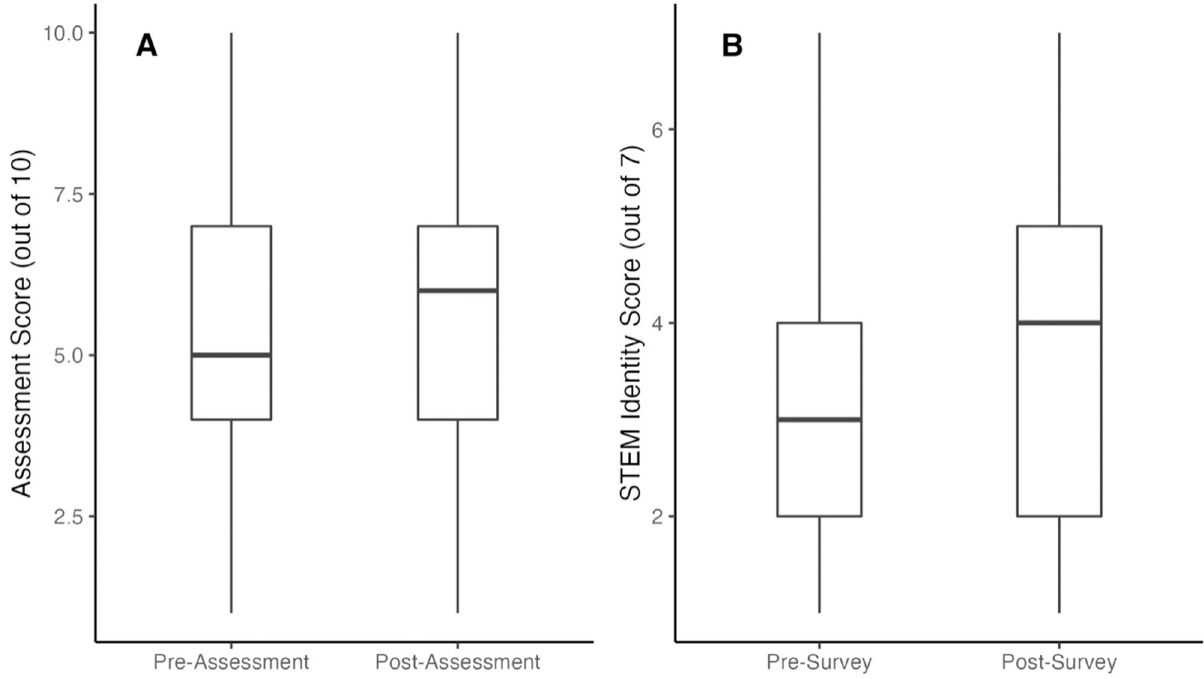
Fig 4. Student raw assessment score (A) and STEM identity score (B) distributions pre- and post- the bioinformatics activity of the PARE-Seq module (Spring 2021). Central bars represent median overall scores, boxes represent inner quartiles, and whiskers represent first and fourth quartiles. T-tests revealed significant differences between time points for both outcomes, indicating that students showed gains in learning and self-rated STEM identity after completing the bioinformatics modules of PARE-Seq.